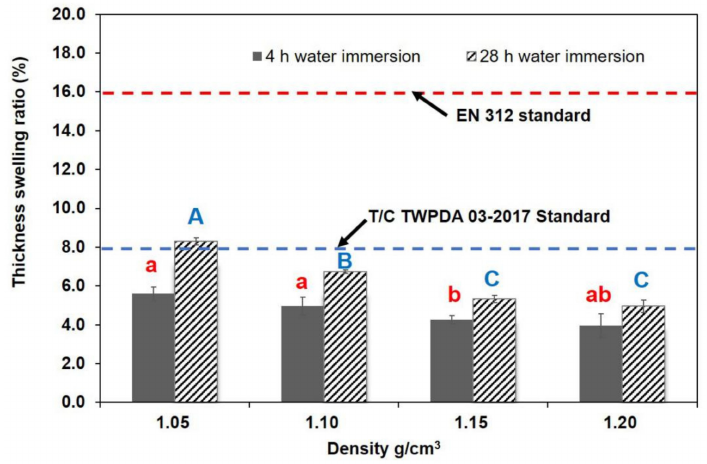
Figure 5. Thickness swelling results at different hot press temperatures (Notes: The same lowercase (4 h water immersion) and capital letter (28 h water immersion) are not significantly different at 5% significance level using Duncan’s post-hoc test).